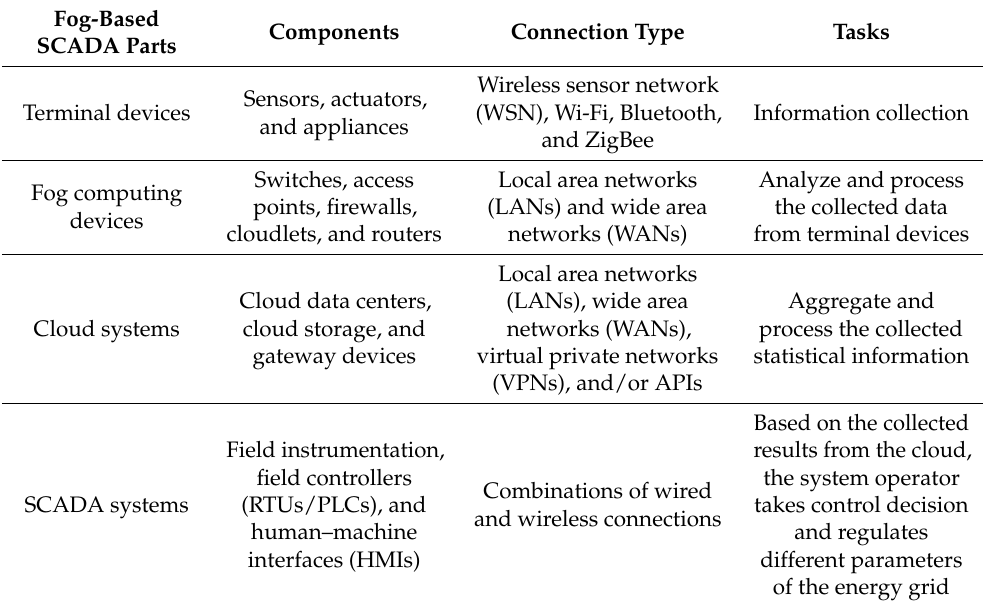
Table 4. Fog-based SCADA system